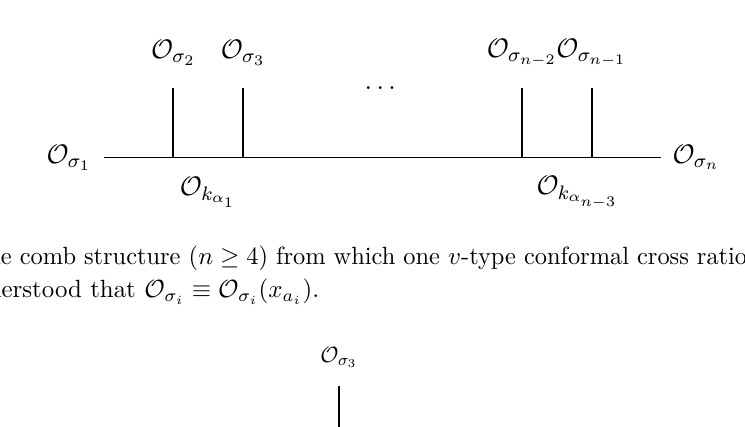
Figure 5 . The associated OPE vertices for the comb structure in figure 4. The coordinates x q must be chosen in a way that is consistent with the OPE, or in other words, the flow of coordinates. Without loss of generality, we assume q